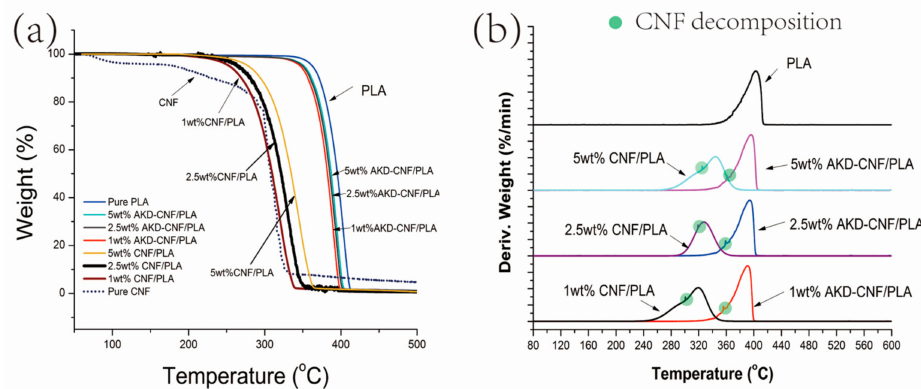
Figure 4. ( a )TGA thermograms for PLA, its nanocomposites with 1, 2.5 and 5 wt.% AKD-CNF, and with 1, 2.5, 5 wt.% unmodified CNF; ( b ) DTG thermograms for PLA and its nanocomposites with 1, 2.5 and 5 wt.% AKD-CNF, and with 1, 2.5 and 5 wt.% unmodified CNF. Table 2. Temperatures at DTG Peaks (Figure 4b) for Reinforced PLA composites. Temperature at DTG Temperature at CNF Sample Peaks ( ◦ C) Decomposition ( ◦ C) PLA 402.6